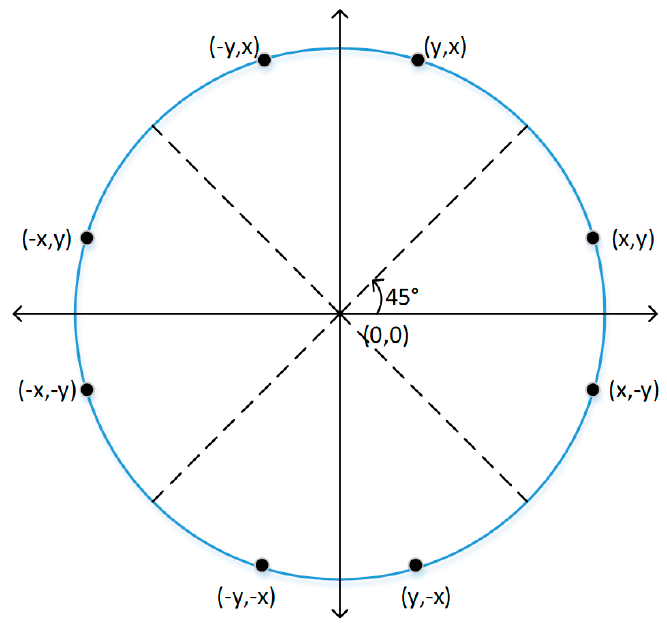
Figure 5. Symmetry property in a circle used in the pixel coordinate generator.